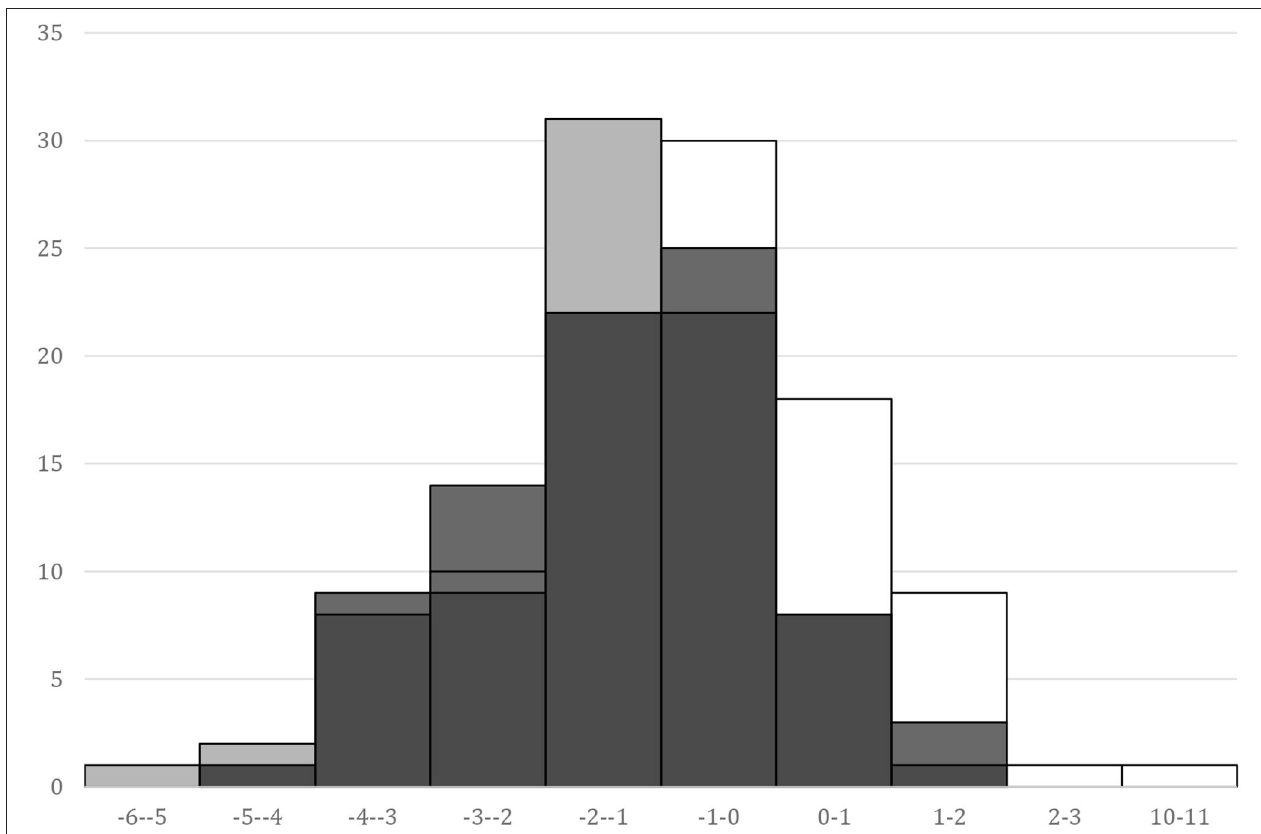
FIGURE 1 | SPhA histograms. “basal,” white – SPhA before kidney transplantation; “dis,” gray – SPhA at the hospital discharge; “6 mo,” black – SPhA after 6 months after kidney